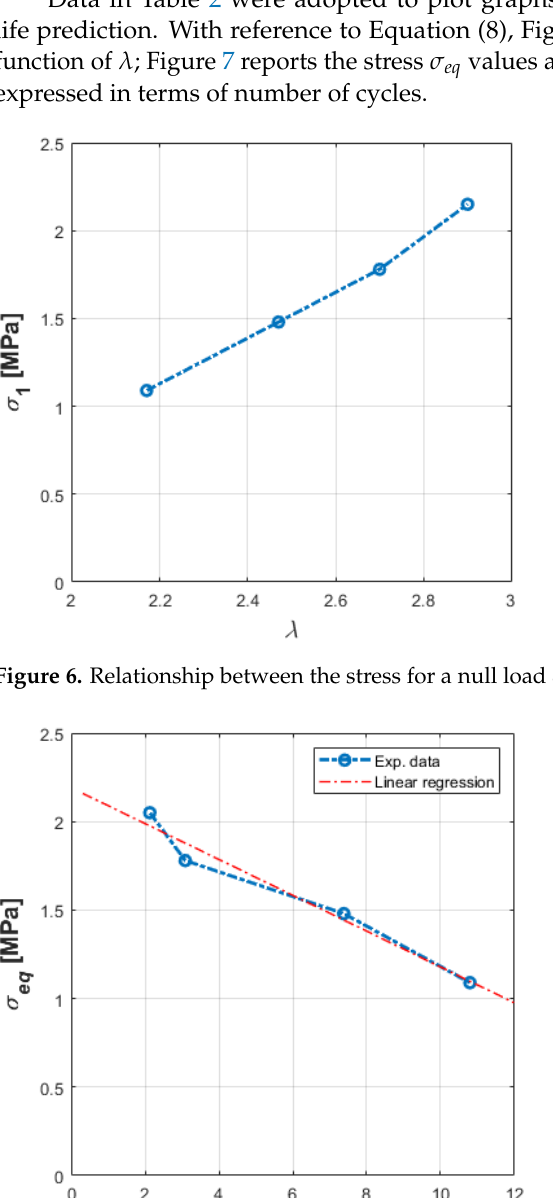
Figure 7. Relationship between the equivalent stress σ eq and the actuator life duration.